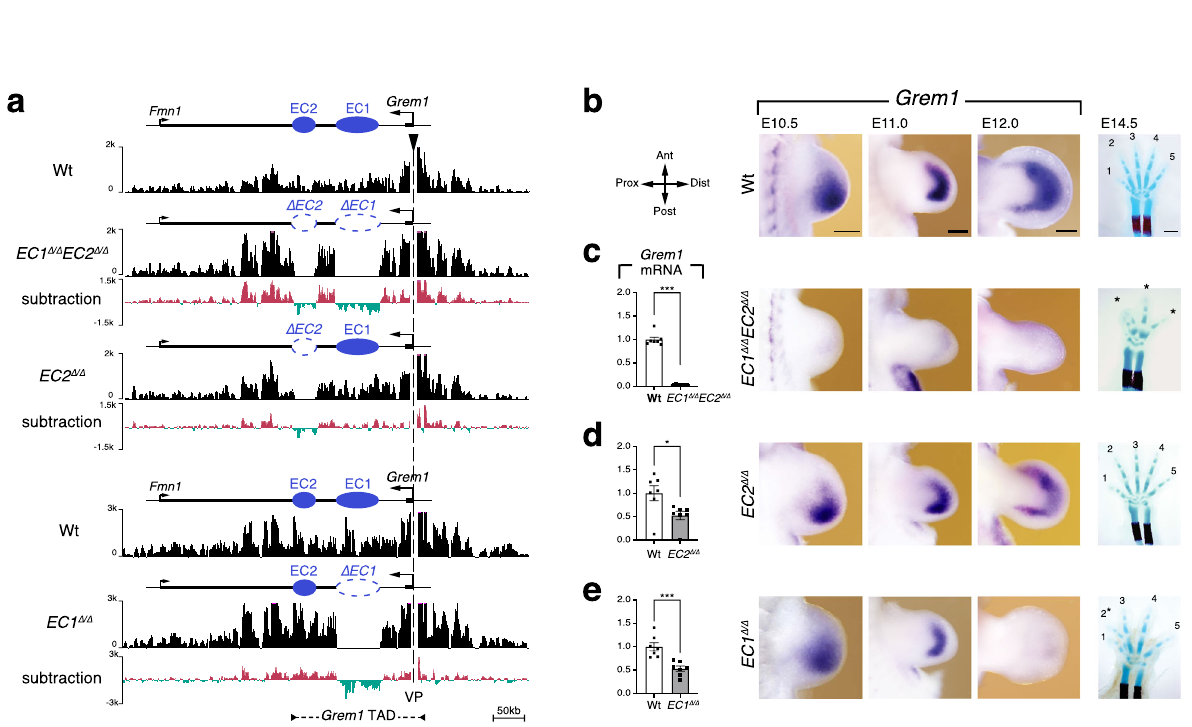
Fig. 2 Two enhancer clusters in the Grem1 TAD control the spatio-temporal dynamics of limb bud mesenchymal Grem1 expression. a Chromatin conformation capture (4C) using the Grem1 promoter as viewpoint (VP, also indicated by a black arrowhead) to reveal its interactions with the Grem1-Fmn1 landscape. The 4C pro fi les of forelimb buds lacking both EC1 and EC2 or EC2 and EC1 alone were compared to their respective wild-type controls (upper Wt: control for EC1 Δ / Δ EC2 Δ / Δ and EC2 Δ / Δ , lower Wt: control for EC1 Δ / Δ forelimb buds). Subtraction after normalization reveals that the deletions do not affect the interactions of the Grem1 promoter with the remainder of the Grem1 - Fmn1 TAD (subtraction, green: reduction or loss of interactions, red: gain of interactions). The position of Grem1 TAD is indicated at the bottom of the panel. b – e Left panels (except b ): RT-qPCR was used to determine the relative Grem1 transcript levels in wild-type and homozygous mutant forelimb buds ( n = 7 independent biological replicates at E11.0, 40 – 42 somites per genotype). Bars represent mean values + / − SEM. P -values were determined using the two-tailed Mann – Whitney test: *** p = 0.000583 (panels c , e ), * p = 0.017483 (panel d ). Middle panels: In situ hybridisation shows the spatio-temporal Grem1 distribution in wild-type (Wt) and mutant forelimb buds at three developmental stages ( n = 4 embryos analysed per genotype and stage from different litters and in minimally two independent experiments). E10.5: 35 – 37 somites; E11.0: 40 – 42 somites, E12.0: staged by developmental time). Ant: anterior, Dist: distal, Post: posterior, Prox: proximal. Scale bars: 250 μ m. Right panels: limb skeletons at ~E14.5 (blue: cartilage, red: ossi fi cation centres in radius and ulna). Digits are shown from anterior (digit 1) to posterior (digit 5). Only three rudimentary digits form in EC1 Δ / Δ EC2 Δ / Δ forelimb buds (indicated by asterisks, n = 5). In contrast, pentadactyly is perfectly maintained in EC2 Δ / Δ forelimbs ( n = 3), while 64% of all EC1 Δ / Δ ( n = 9/14) forelimb skeletons display variable fusions of digits 2 and 3 (asterisk). Scale bar: 1 mm. RT- qPCR source data are provided in a Source data fi